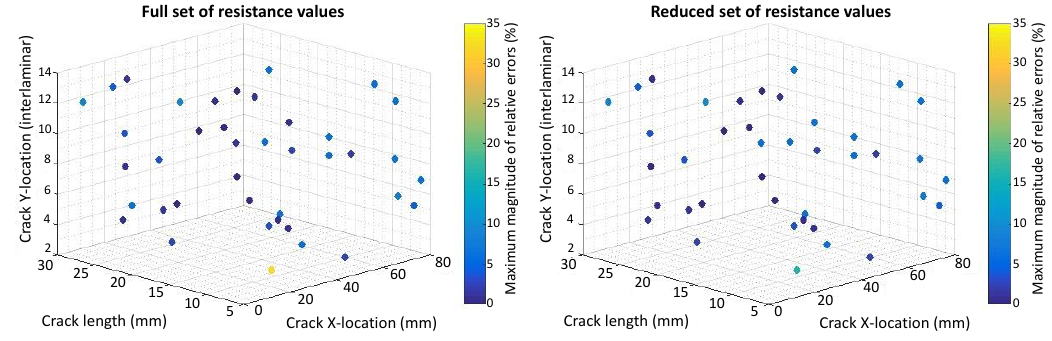
Figure 8. Scatter plot with maximum magnitude of relative errors obtained at the 40 test points used for inverse identification in a [ 0 4 /90 4 ] s laminate using 14 electrodes and considering: ( left ) Full resistance measurement set; ( right ) Reduced resistance measurement set using EI.